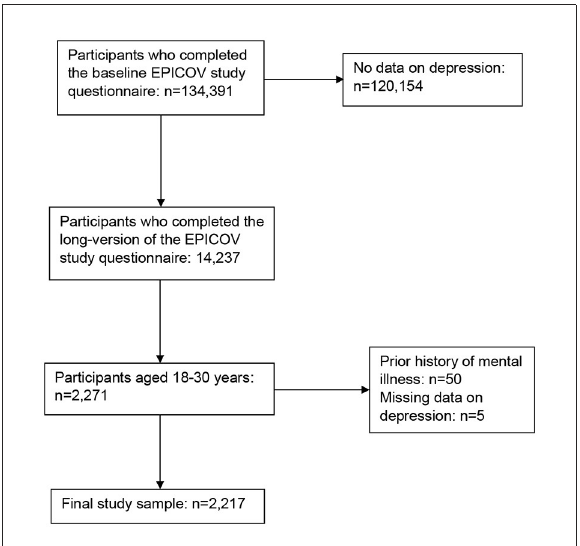
FIGURE1 Flowchart showing the selection of EPICOV study participants aged 18–30 years and with available depression data.